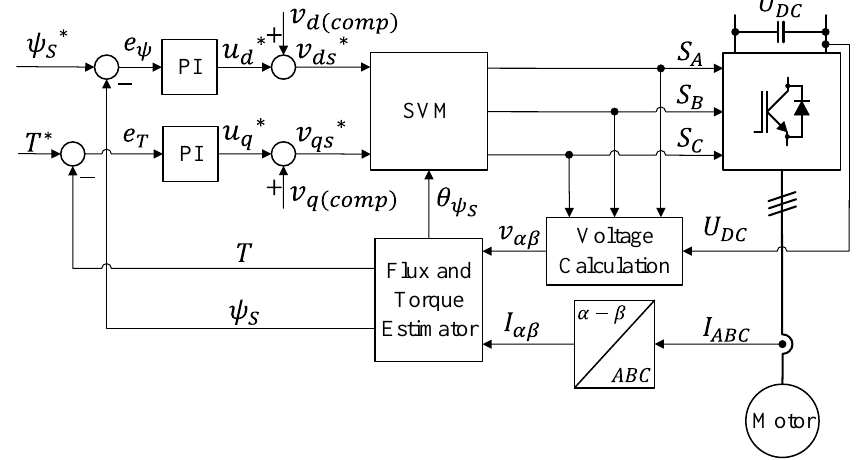
Figure 3. DTC – SVM scheme operated in stator flux cartesian coordinates.